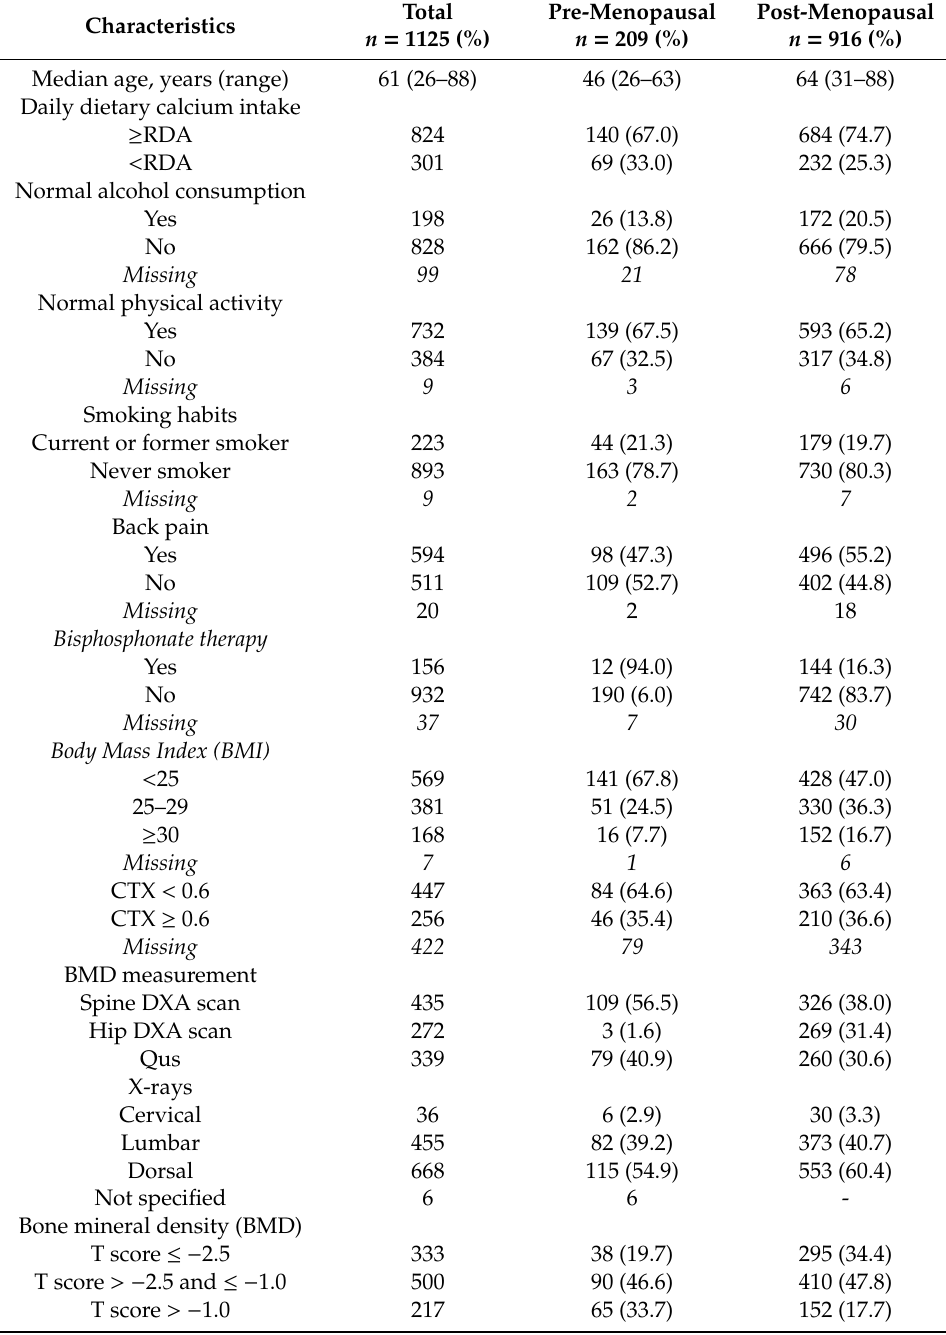
Table 1. Patient characteristics ( n =